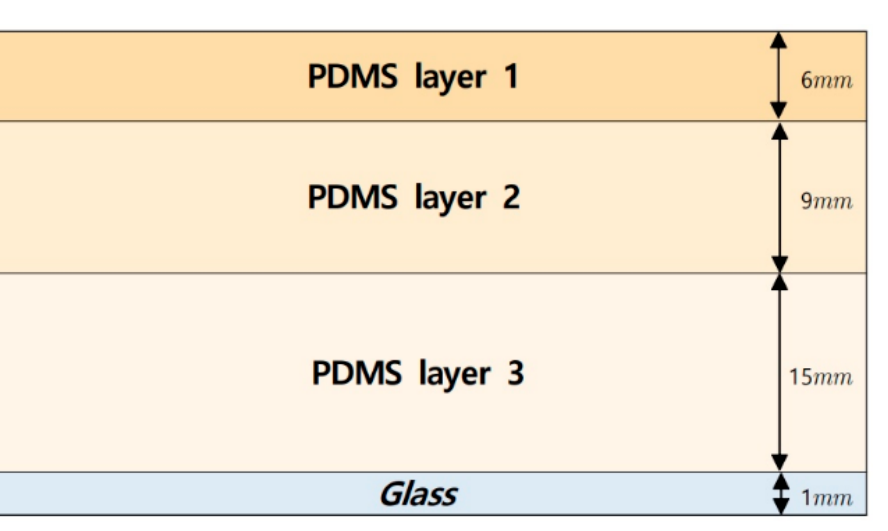
6 of 28 Figure 3. Schematic of the optical tactile sensor.